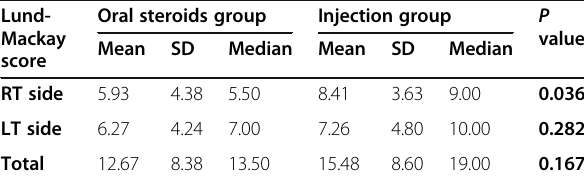
Table 8 Lund-Mackay score after treatment in both groups Lund- Oral steroids Mackay score